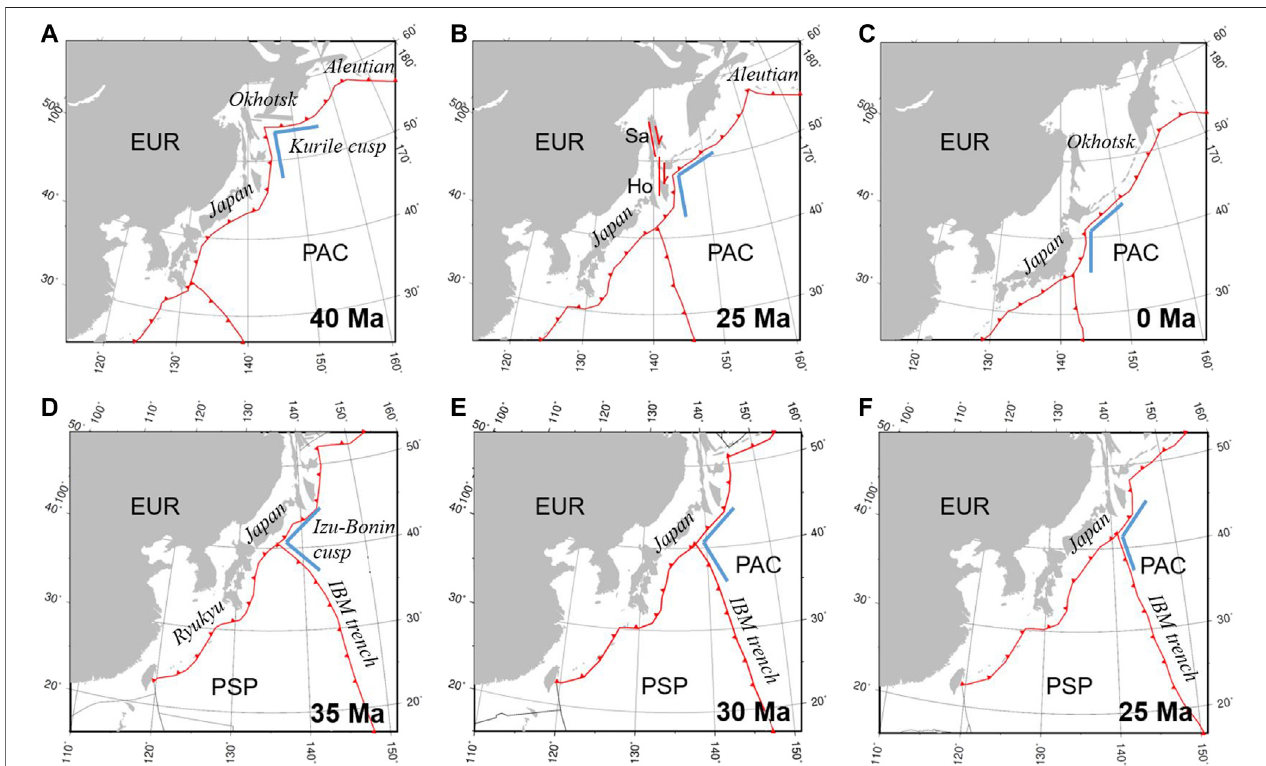
FIGURE1|(A) , (B) ,and (C) showtheplate boundarycon fi gurationsneartheKurileIslandsat (A) 40 Ma, (B) 25 Ma,and (C) 0 Ma(afterVaeset al.,2019). (D) , (E) , and (F) showplate reconstruction results nearthePhilippine Sea plateat (D) 35 Ma, (E) 30 Ma, and (F) 25 Ma(afterMülleret al.,2016).Red lineswith fi lledtrianglesand arrows represent trenches and strike-slip faults, respectively.The Kurile and Izu-Bonin cusps are represented by blue angles. Abbreviations: PAC (cid:1) Paci fi c plate; EUR (cid:1) Eurasian plate; PSP (cid:1) Philippine Sea plate; Sa (cid:1) Sakhalin; and Ho (cid:1) Hokkaido.